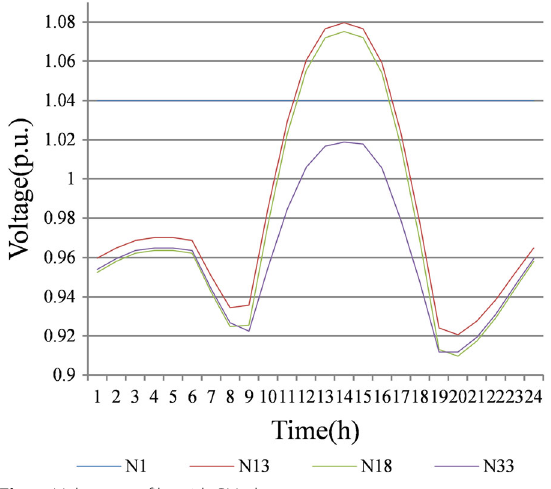
Fig. 7 Voltage profile with PV plants